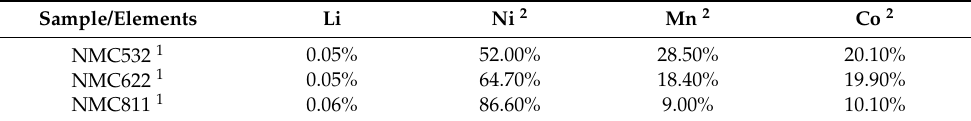
Table 3. Chemical composition of the obtained metal phase in the conducted experiments (mass fraction, wt.%). Sample/Elements